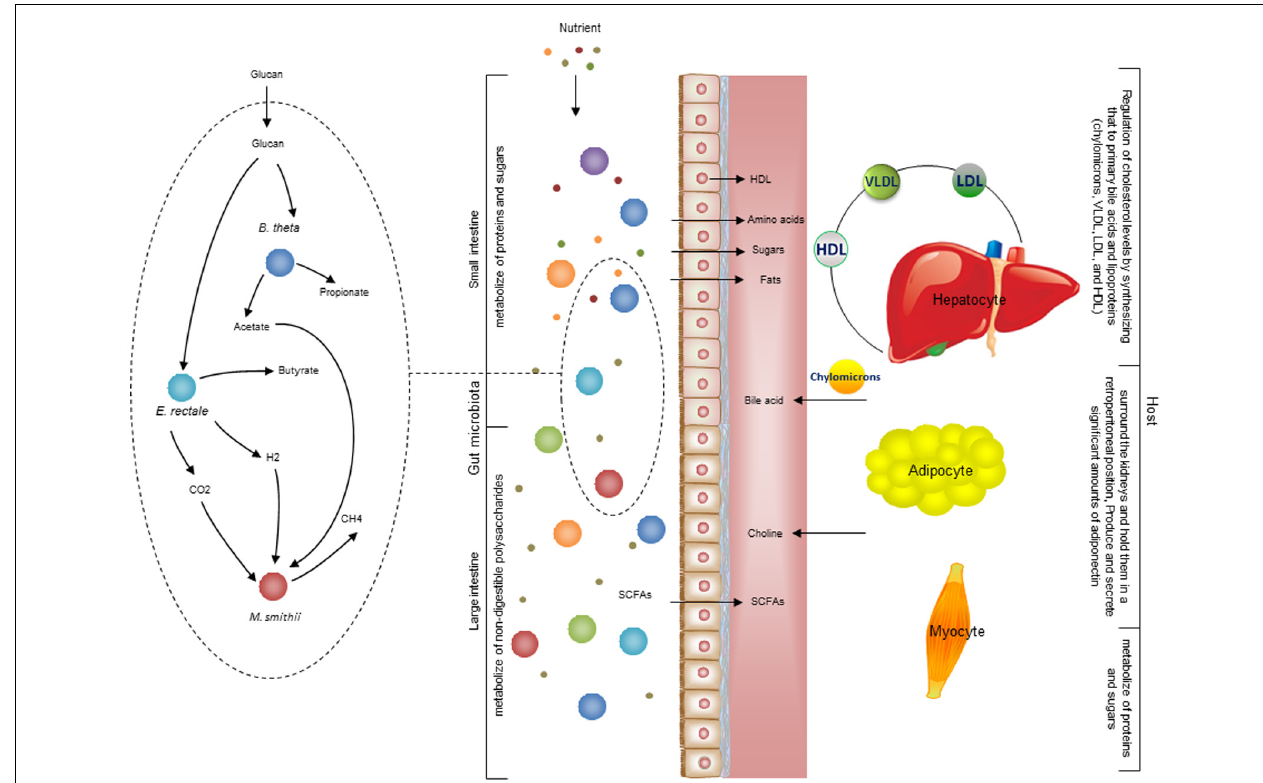
digested by host enzymes and indigestible ones are degraded by the microbiota. This process initiates mainly in the stomach and continues significantly through the small and large intestine. The available SCFAs are transported to liver through the portal vein. Since hepatocyte regulate cholesterol levels by synthesizing primary bile acids and lipoproteins [chylomicrons, very low-density lipoprotein (VLDL), low-density lipoprotein (LDL), and high-density lipoprotein (HDL)] 28 . It is very likely that the production of acetate and other compounds by the microbiome profoundly impacts this regulation. There is also a crosstalk between adipocytes and myocytes through free fatty acid transport. Understanding these interactions between organs is necessary to overcome the complexity of metabolic modeling the interaction between host and gut